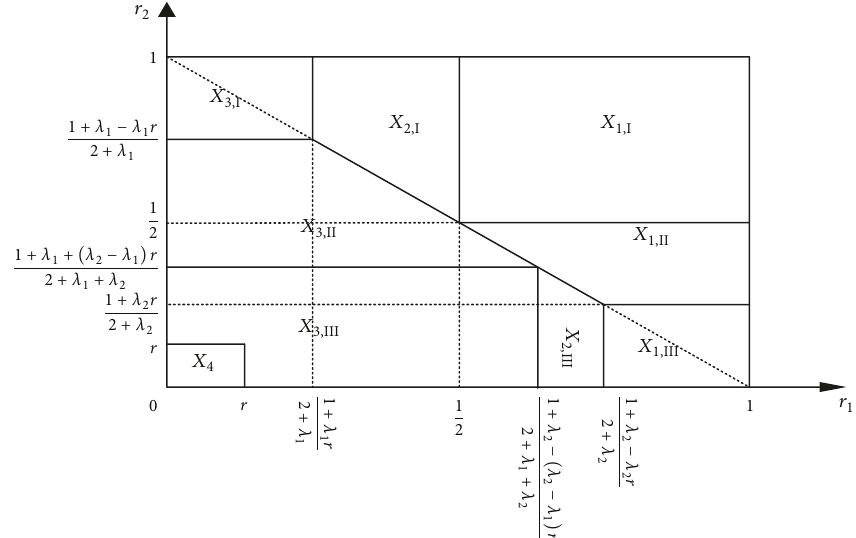
Figure 4: The equilibrium partitions for 𝛿 󳨀→ 1 , with 𝜆 2 > 𝜆 1 and 𝑟 fl 𝑟 0 1 = 𝑟 0 2 .